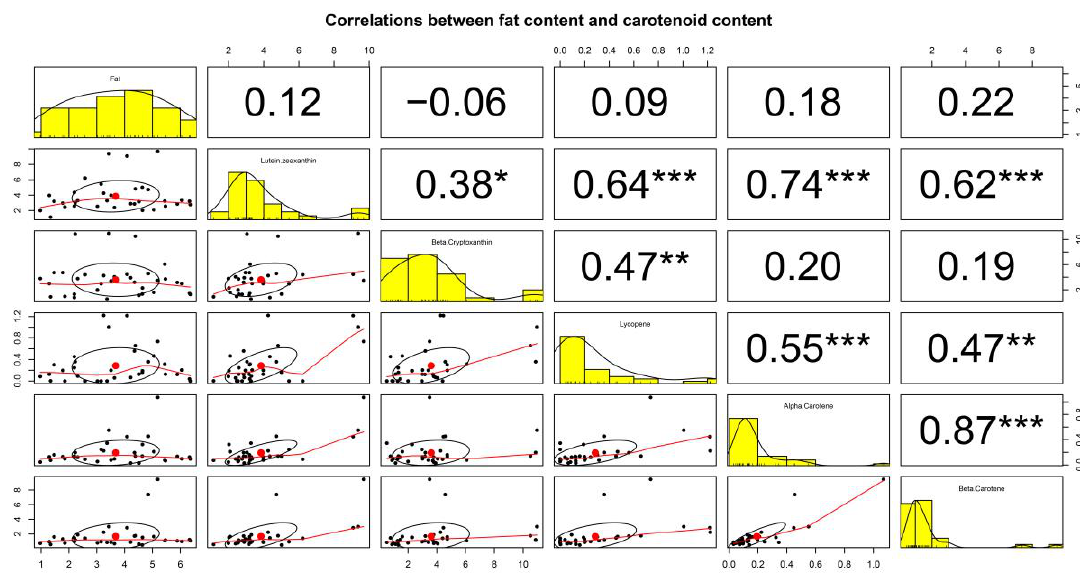
Figure 2. The correlations between fat content and carotenoid content in human milk (HM) from mothers in Korea are graphically shown. The x-axis in each scatter plot represents the column variable, the y-axis the row variable. A histogram of values is represented on the diagonal. The points in the middle of the ellipse below the diagonal represent the points determined by the mean values of the x-axis and y-axis variables. The correlation between two variables is represented by the shape of the ellipse; the more the ellipse is stretched, the stronger its correlation. The curve drawn by the scatter plot represents the general relationship between the x-axis and y-axis variables. The number at the top of the diagonal represents the Pearson correlation coe ffi cient between the x-axis and y-axis variables. *, **, and *** represents significant correlations at p < 0.05, p < 0.01, and p < 0.001, respectively.